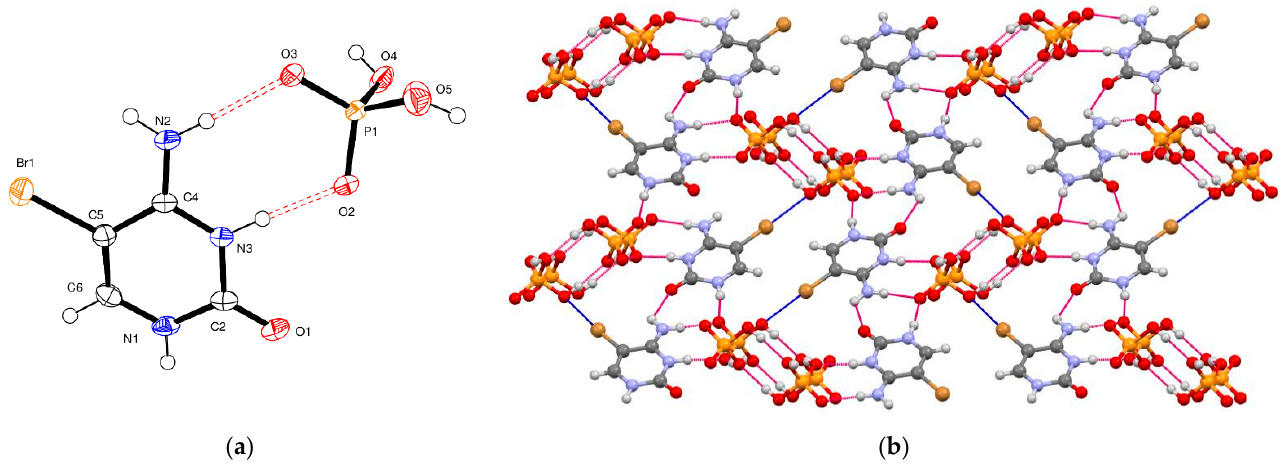
Figure 5. ( a ) The asymmetric unit of compound ( V ), showing the adopted atom-numbering scheme. Displacement ellipsoids are at the 50% probability level. H atoms are shown as small spheres of arbitrary radii. Hydrogen bonding is shown as red dashed lines. ( b ) Part of the crystal structure of ( V ). All atoms are shown as small spheres of arbitrary radii. Hydrogen bonding is shown as red dashed lines. Halogen bonding is shown as blue dashed lines.